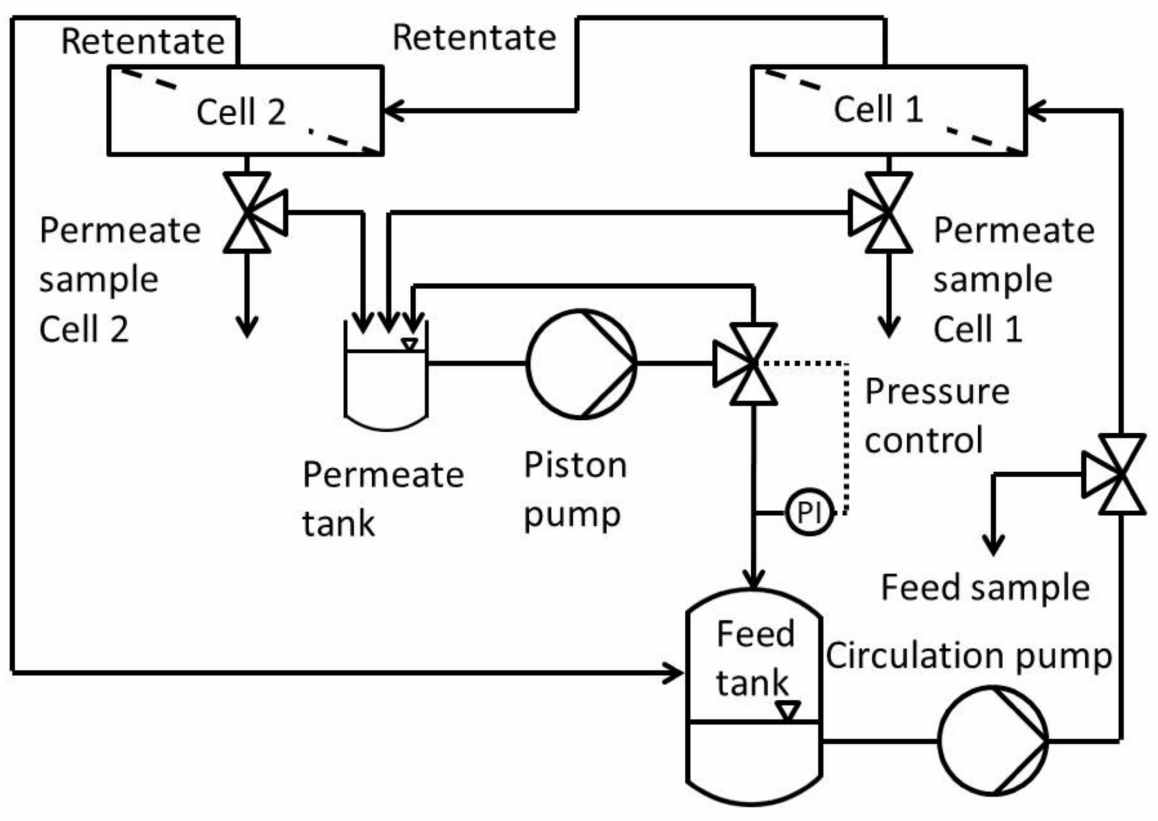
Figure 1. Process scheme of the modified cross flow setup of Evonik MetCell ® test